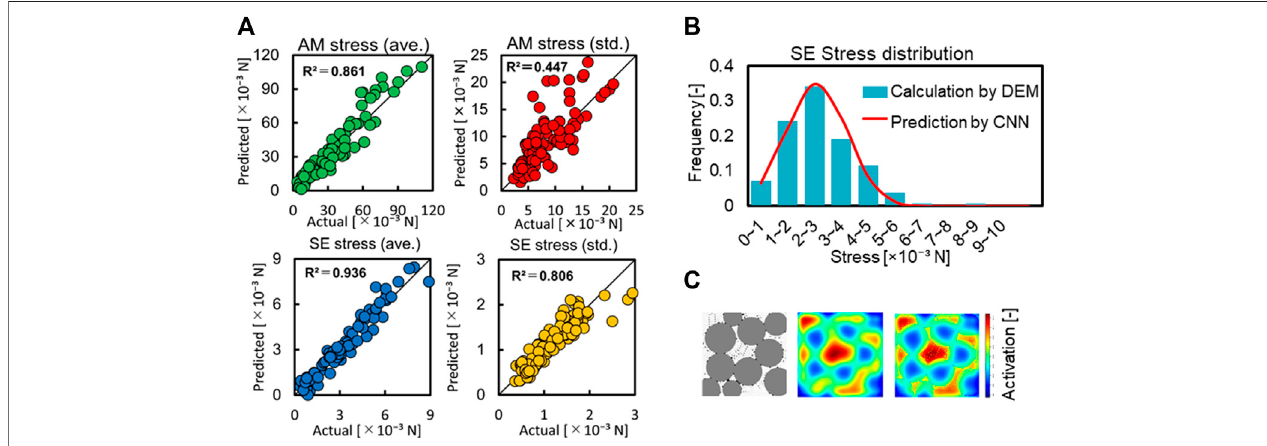
FIGURE4|(A) ComparisonbetweencontactstressespredictedbyCNNandcalculatedbyDEM. (B) StressdistributionofSEsin Panel2C . (C) Visualizationofthe region of interest. As shown by the red area, CNN training has taken place.